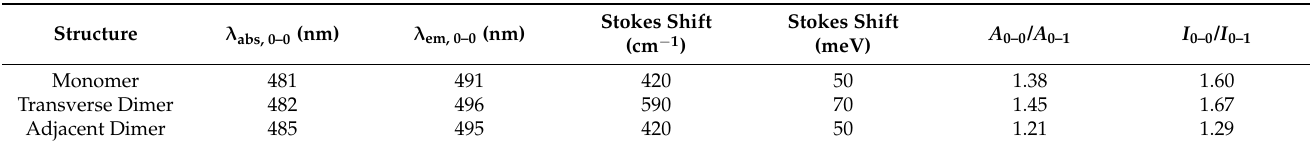
Table 1. Steady-State Absorption and Fluorescence Emission Characterization of DNA-Templated Perylene Monomer and Adjacent and Transverse Dimers.